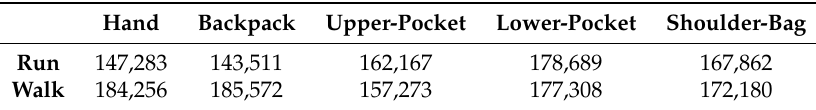
Table 1. Statistics of the raw